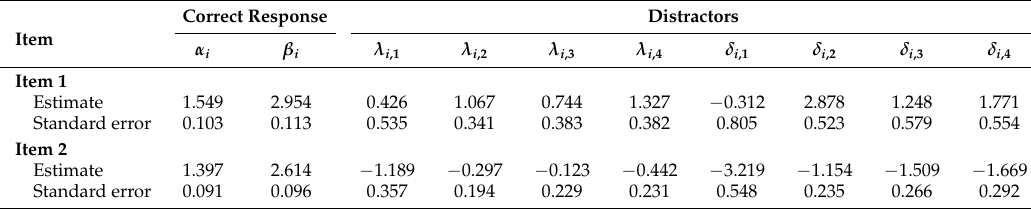
Table 4. Item parameters of the 2PNL